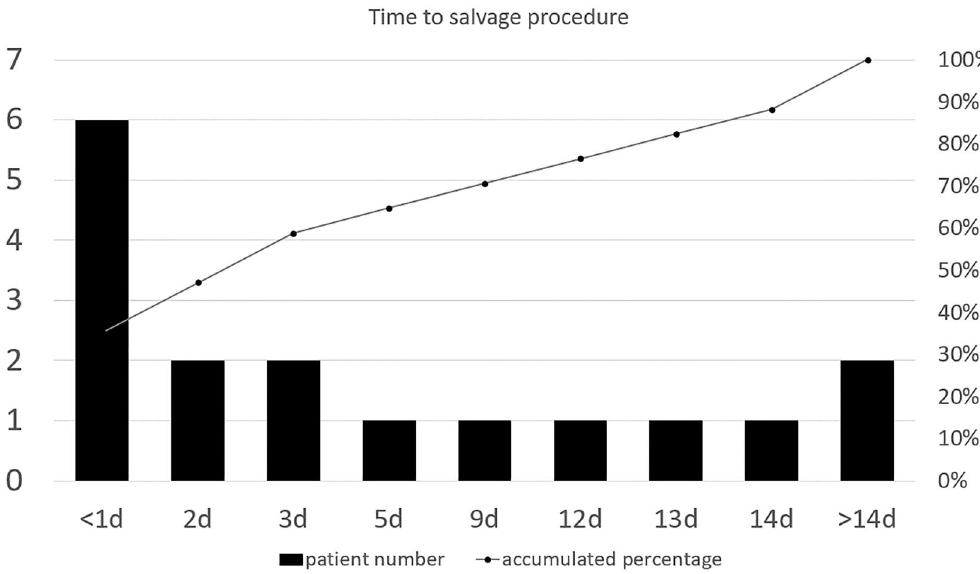
Figure 2. Time from admission to salvage procedure expressed as number of patients within each time period. Over 60% of the salvage procedures were performed within 5 days after injury.